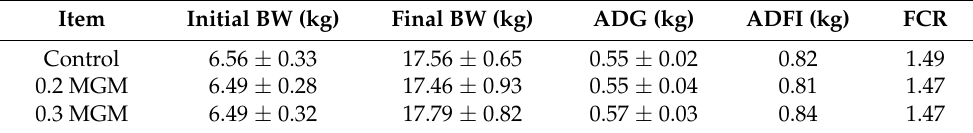
Table 5. Effects of MGM-P supplementation on growth performance in weaned